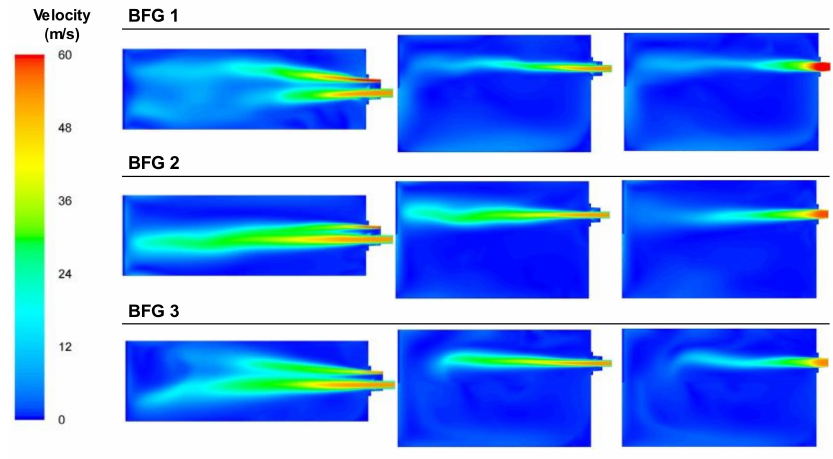
Figure 11. Contour plots of velocities for the BFG cases in the XZ1, XY1, and XY2 planes. Figure 12 shows the temperature plots that, in general, looked similar for the three cases throughout the furnace because of the small differences in the power inputs of those cases. The area with the maximum temperature was located between the fuel/primary air stream and the secondary air stream, which was introduced and preheated at temperatures over 500 ◦ C. Combustion started with the primary air and continued when it reached the heated oxygen introduced via the secondary air duct. Both Figures 11 and 12 show long flames, where the swirl effect induced by the primary air’s rotation was not enough to break the inertia of the high fuel flow. Thus, the flame extended and shifted closer to laminar combustion patterns.